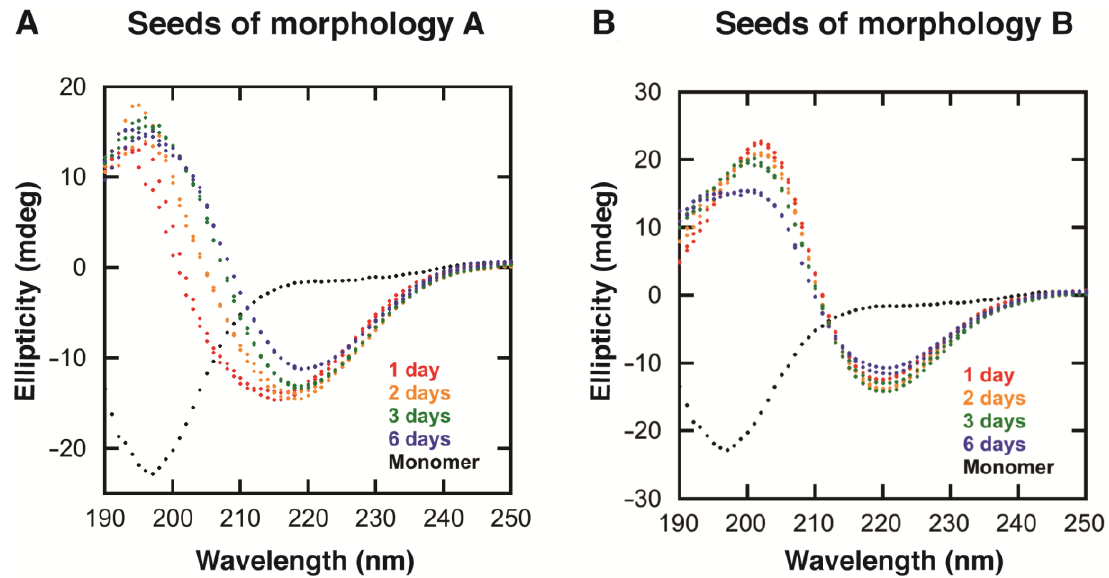
Figure 4. The replication of morphologies A and B using 1% seed. The different graphs show CD spectra of the monomeric sample (black), supplemented with 1% seeds of morphology A or 1% seeds of morphology B before incubation at 37 °C with stirring for 6 days. The CD spectra were measured after 1 day (red), 2 days (orange), 3 days (green), and 6 days (blue). Apart from the monomer, two replicates are shown for each time point.